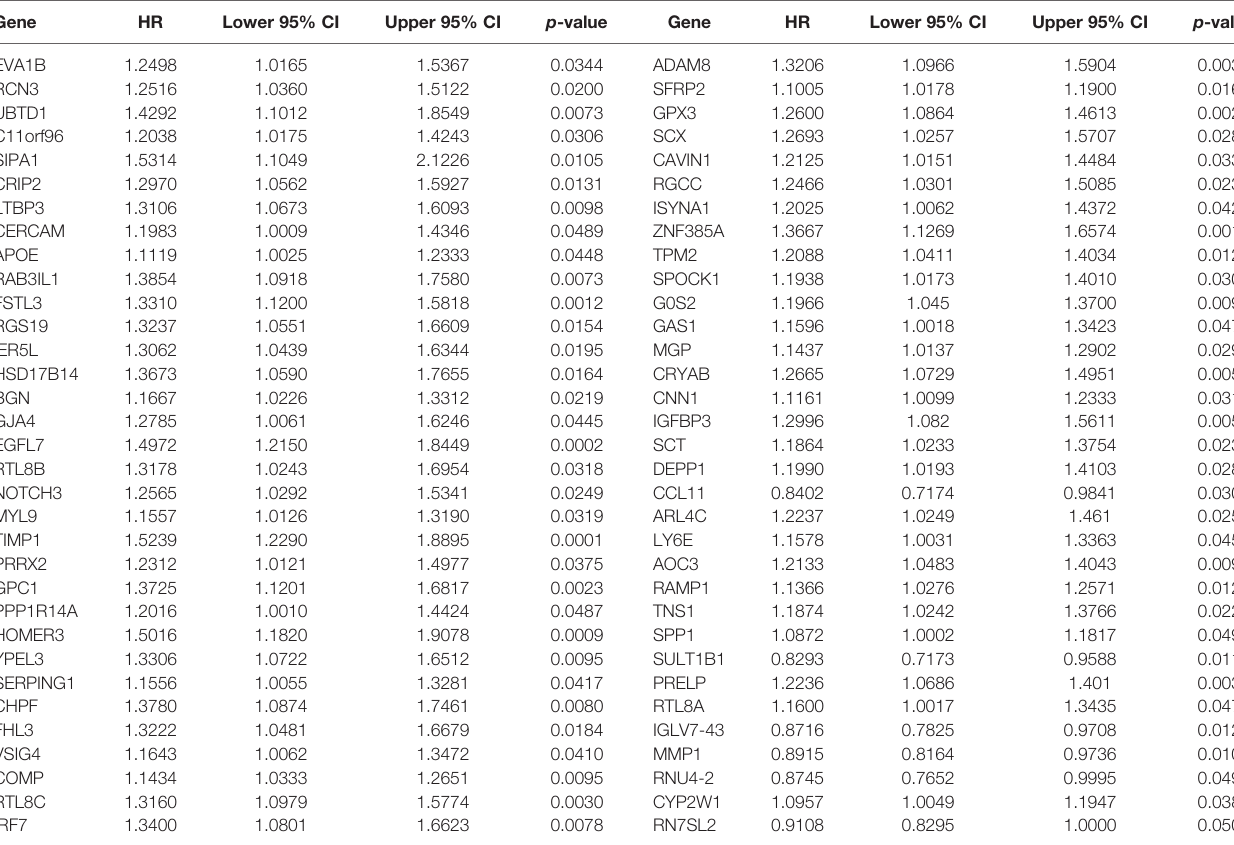
TABLE 1 | Univariate-Cox regression models determine prognostic EVA1B-derived genes in